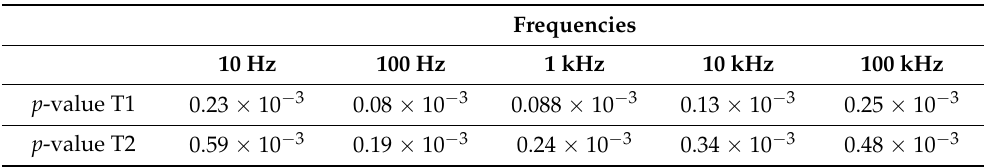
Table 4. p -Values from the two tests conducted to assess the significance of the variation between the forward experiment, the reverse, and the hyperhydration